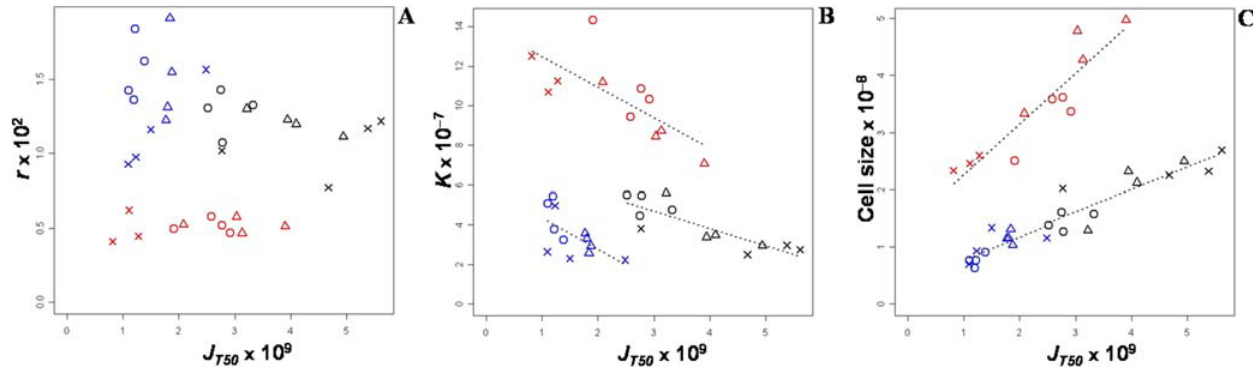
Figure 3. Correlations between glucose consumption rate and growth rate per cell (A), carrying capacity (B) and cell size (C). Each point corresponds to the mean value of a strain in a culture condition. Blue, black and red colors correspond respectively to 0.25%, 1% and 15% glucose. Vinery strains are represented by circles, brewery ones by crosses and bakery ones by triangles.